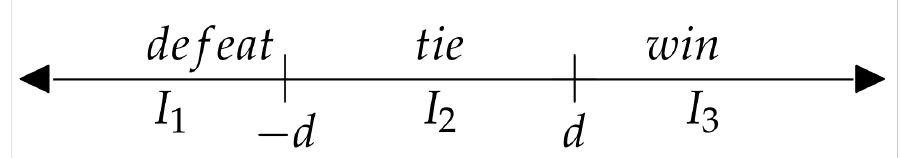
Figure 1. The possible results and the intervals belonging to